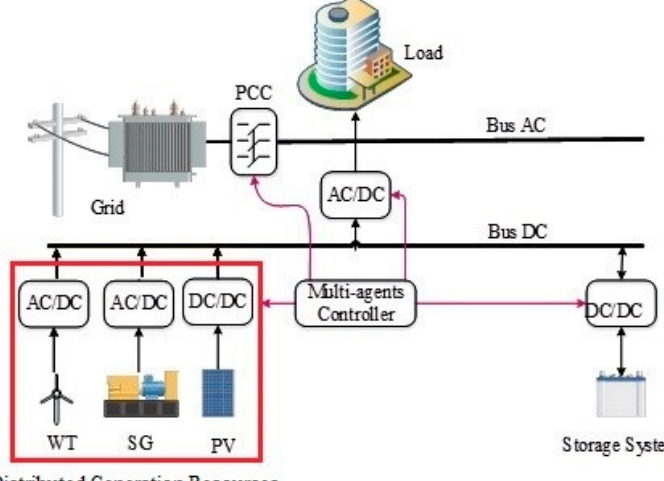
Figure 3. The configuration of the DC microgrid under study.